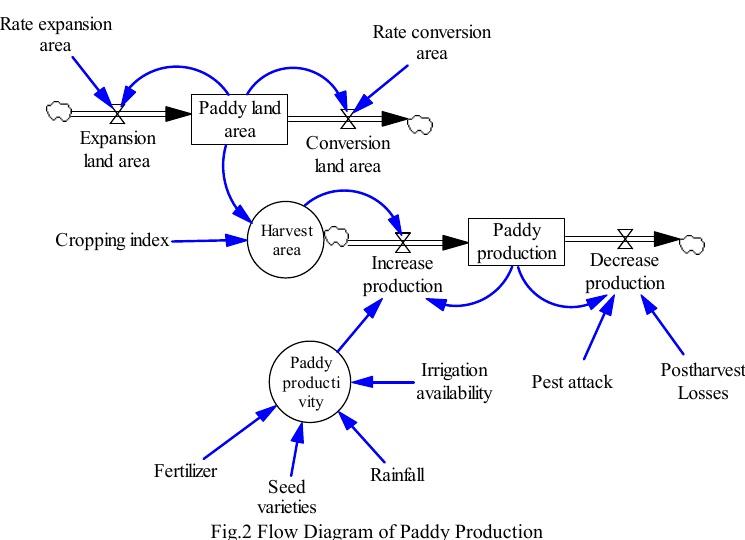
Fig.2 Flow Diagram of Paddy